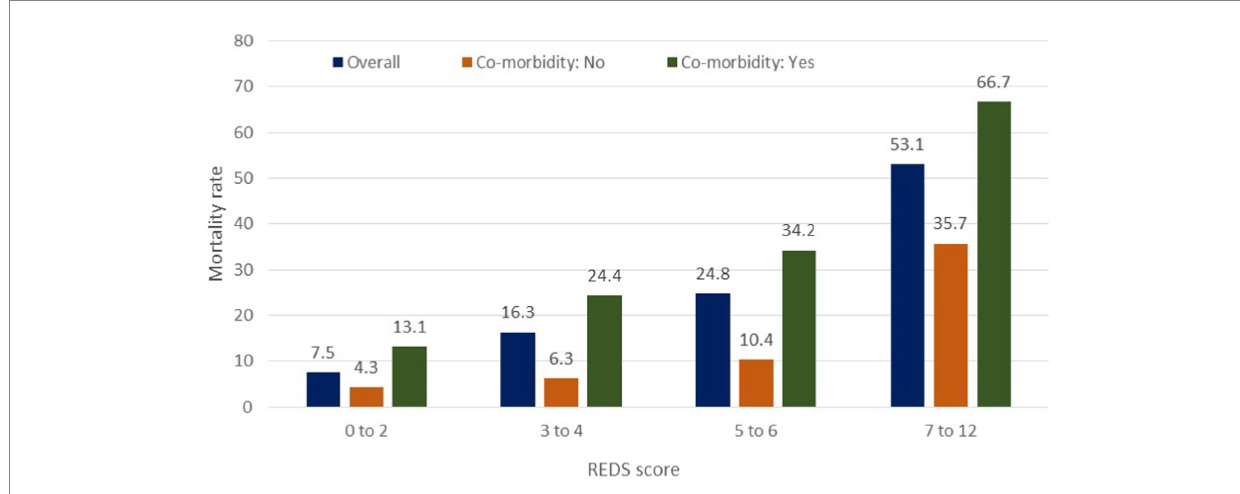
FIGURE 7 In-hospital mortality rates by the REDS score in patients with and without specified* co-morbidities. *Specified comorbidities = presence of any one of the following: dementia, malignancy, care home residency or a minimum three times a day care package, on long-term oxygen therapy (LTOT) or a previous do-not-resuscitate decision.